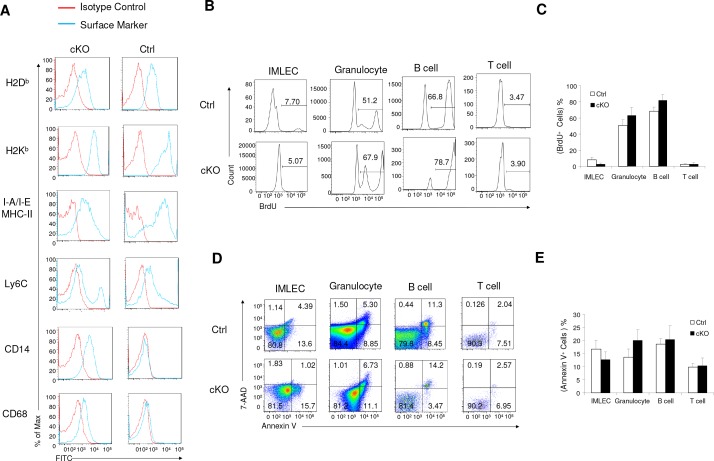
Comparisons of surface markers, viability and cellular proliferation among IMLECs and other defined lineages.(A) IMLECs from Raptor Ctrl and cKO BM displayed comparable expression levels of MHC-I, MHC-II and other surface markers (Ly6C, CD14 and CD68). Data shown are representative of 3 independent experiments. (B, C) IMLECs from Raptor Ctrl and cKO BM exhibited much slower proliferation than other BM lineages. Representative flow profile (B) and summary data (C) are from BrdU incorporation assays. (D, E) IMLECs from Raptor Ctrl and cKO BM were more prone to apoptosis than other BM lineages. Representative flow profile (D) and summary data (E) are from Annexin V and 7-AAD staining. B cells, B220+ BM cells; T cells, CD3+ BM cells; Granulocytes, CD11b+Gr-1+ BM cells. n = 5 for Ctrl mice; n = 5 for cKO mice.